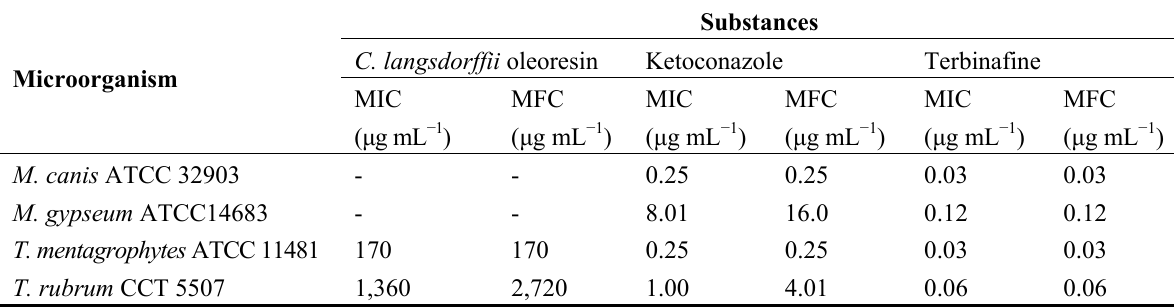
Table 2. Antifungal activity (minimal inhibitory concentration and minimal fungicidal concentration) of C. langsdorfii oleoresin and reference drugs. Substances C. langsdorffii oleoresin Ketoconazole Terbinafine Microorganism MIC MFC MIC MFC MIC MFC ( μ g mL − 1 ) ( μ g mL − 1 ) ( μ g mL − 1 ) ( μ g mL − 1 ) ( μ g mL − 1 ) ( μ g mL − 1 ) M. canis ATCC 32903 - - 0.25 0.25 0.03 0.03 M. gypseum ATCC14683 - - 8.01 16.0 0.12 0.12 T. mentagrophytes ATCC 11481 170 170 0.25 0.25 0.03 0.03 T. rubrum CCT 5507 1,360 2,720 1.00 4.01 0.06 0.06 MIC: minimum inhibitory concentration. MFC: minimum fungicide